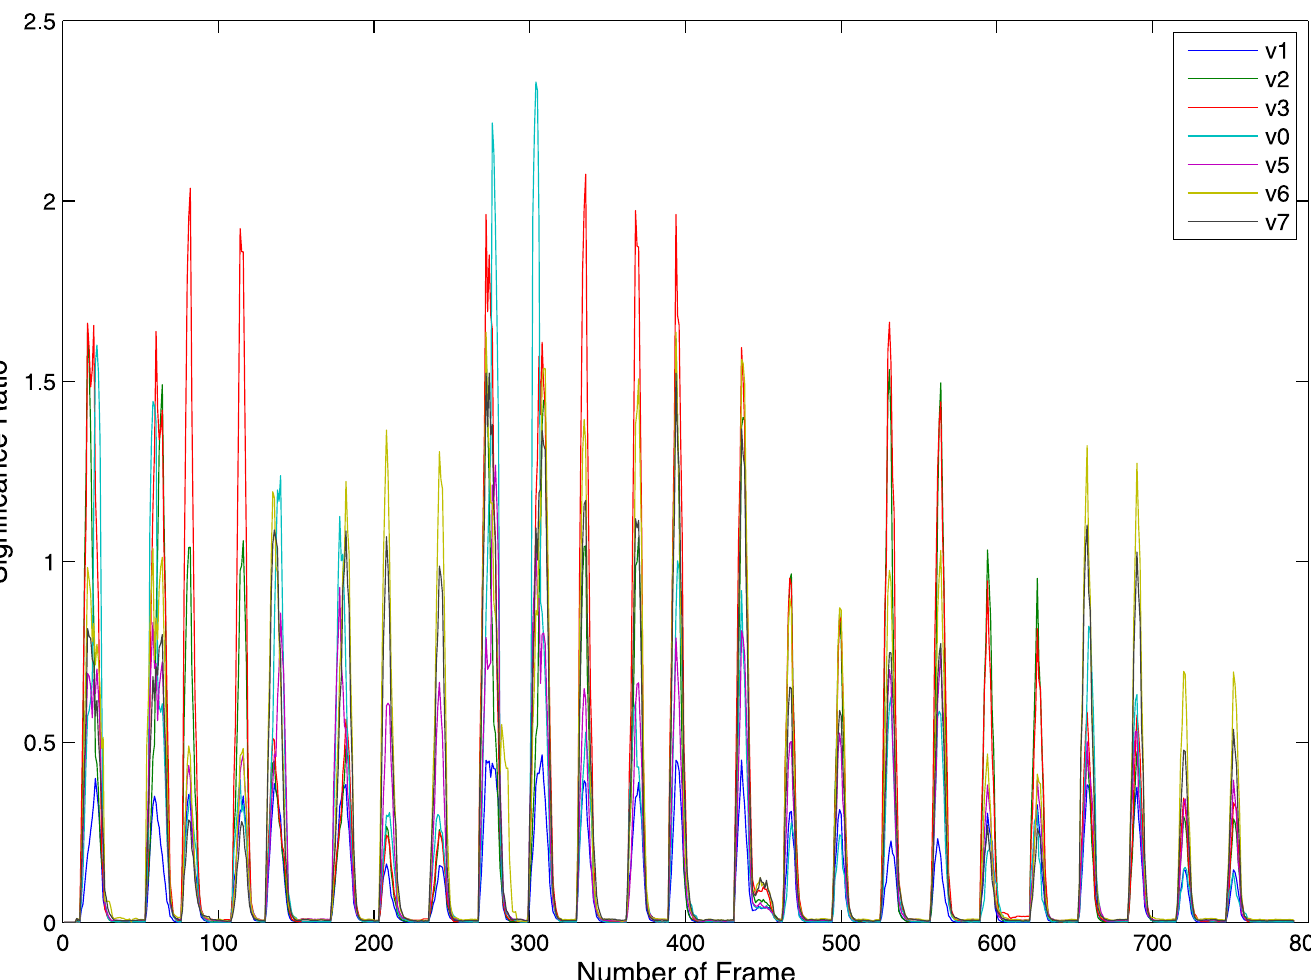
Fig 11. Segmentation through Inc-KSFA for different view perspectives, v1, v2, v3, v4, v5, v6, v7 represents different viewpoints while v0 represents the